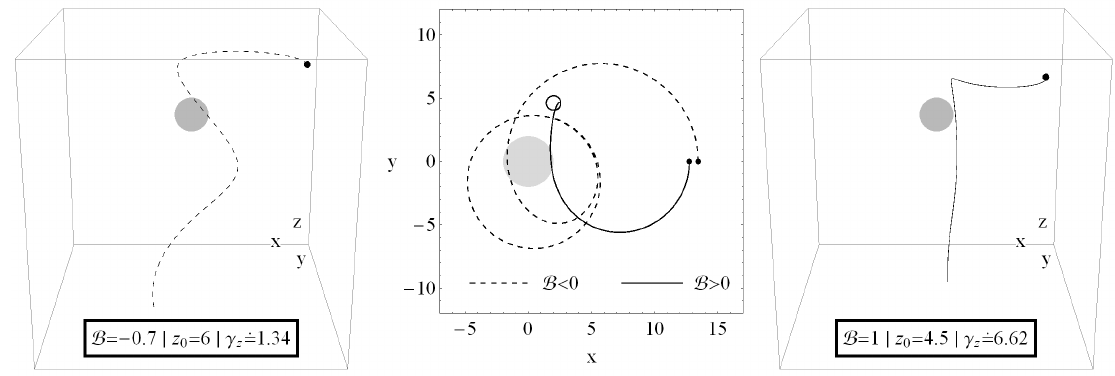
Figure 3. Trajectories of charged particles with negative ( left ) and positive ( right ) magnetic parameter B = qBGM / ( mc 4 ) escaping black hole along z axis. Numerical values of corresponding Lorentz factors are given inside the plots. ( middle ) The projections of both trajectories in the x − y plane. The figure is reproduced from